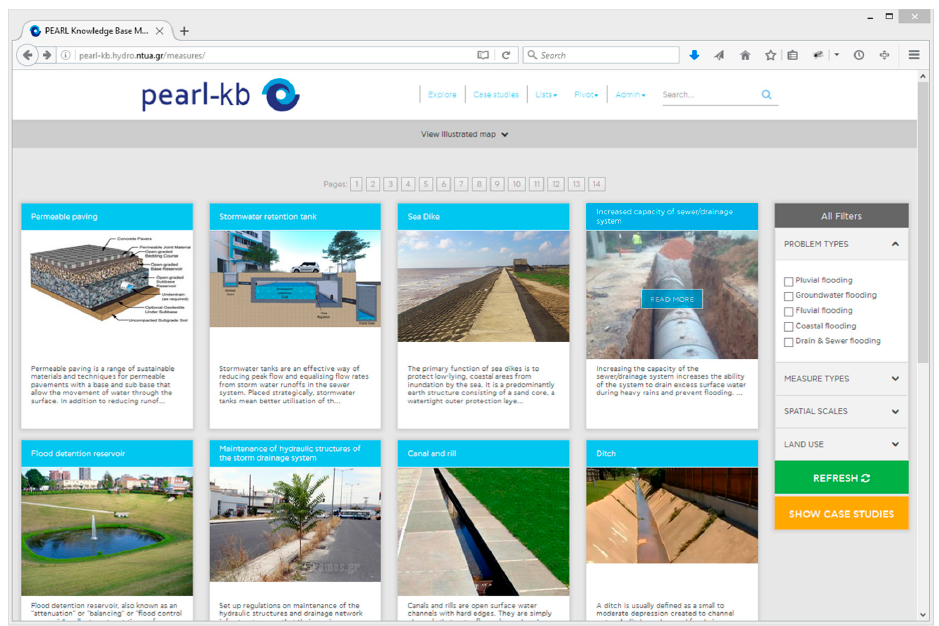
Figure 4. Navigating through the repository of measures.